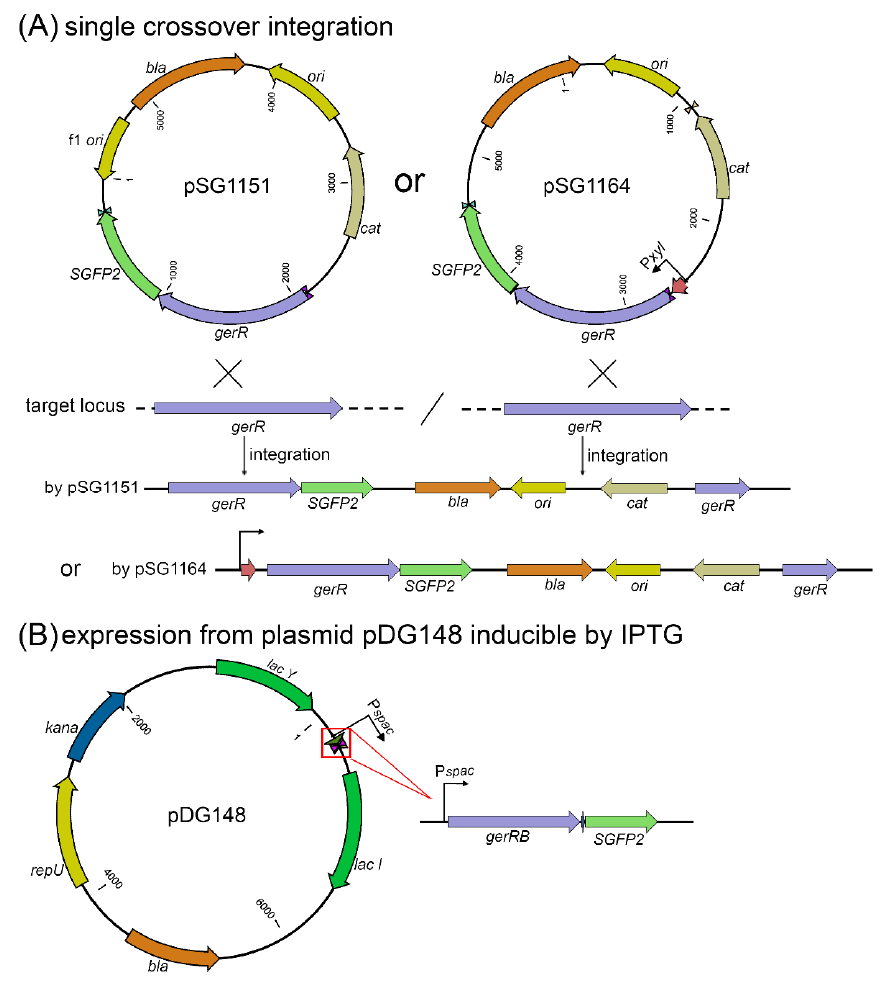
Figure 2. The workflow to construct integration and expression recombinant plasmids in this study. ( A ) The expected single crossovers into the B. cereus genome with integration vectors pSG1151 and pSG1164. Note that pSG1164 contains a xylose-inducible promoter. ( B ) The map of vector pDG148 with the gerRB - SGFP2 fusion gene driven by the P spac promoter and inducible by IPTG.